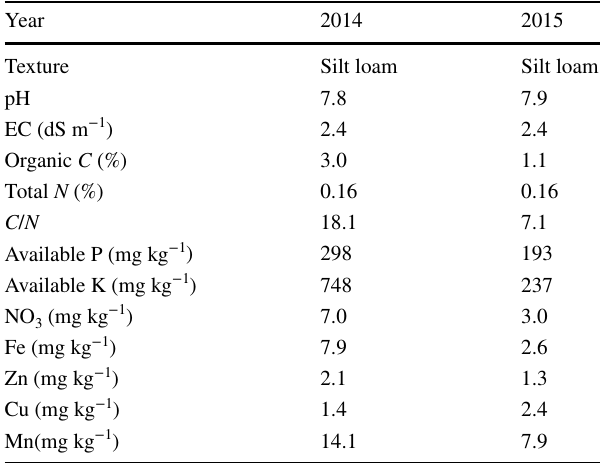
Table 1 Soil properties of the experimental field in the depth of (0–30 cm)